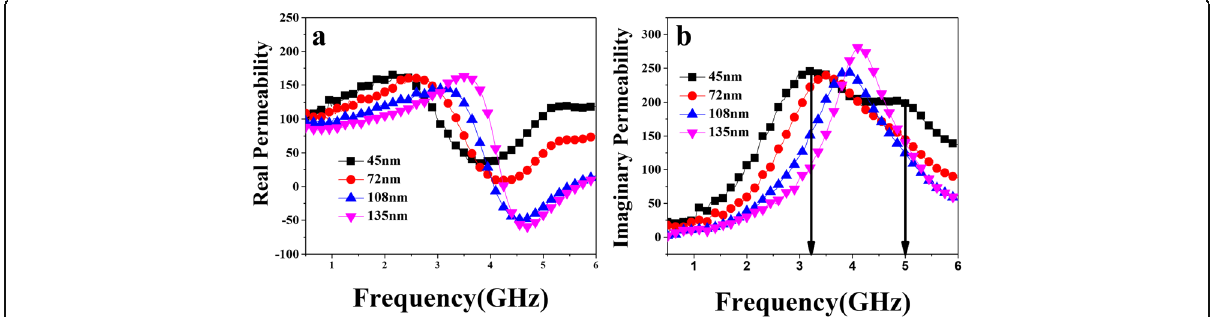
Fig. 3 Permeability spectra measured at room temperature of combined stripe patterned FeCoBSi thin films with various thickness reveal the real permeability of films ( a ) and exhibit the imaginary permeability ( b